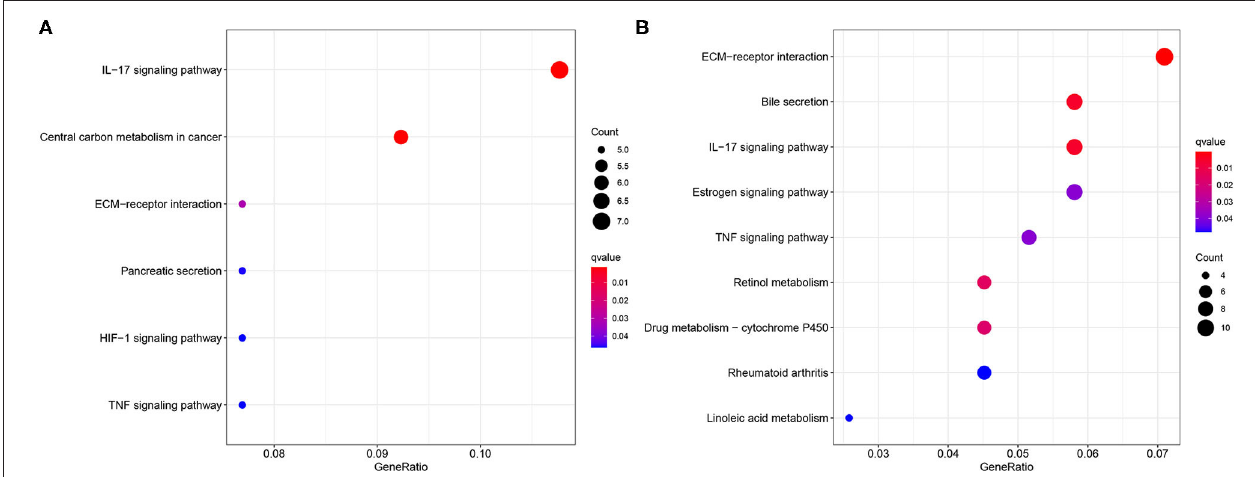
FIGURE 8 | Enrichment of the Kyoto Encyclopedia of Genes and Genomes (KEGG) analysis. Bubble plot of the KEGG analysis based on (A) the TCGA dataset and (B) the ICGC dataset.